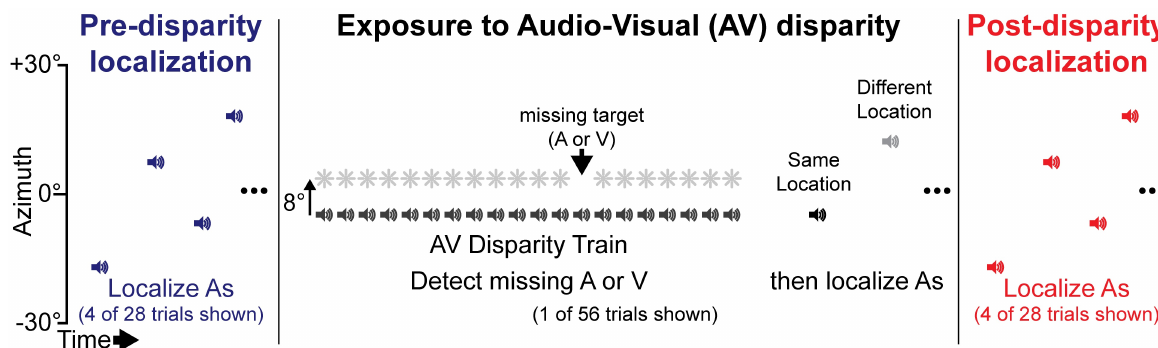
Fig 1. Experimental timeline. In each experimental session, subjects localized auditory targets (represented by speaker symbols) at a range of azimuths before and after repeated exposure to an audio-visual spatial disparity, to observe long-term shifts in auditory perception produced by exposure. Subjects also localized auditory targets following each AV disparity, to observe the effect of each disparity on auditory perception.